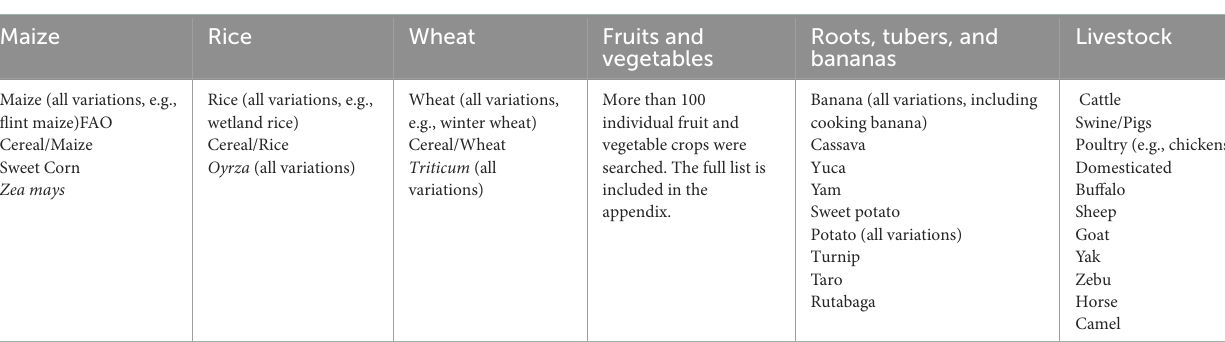
TABLE 2 Crops per